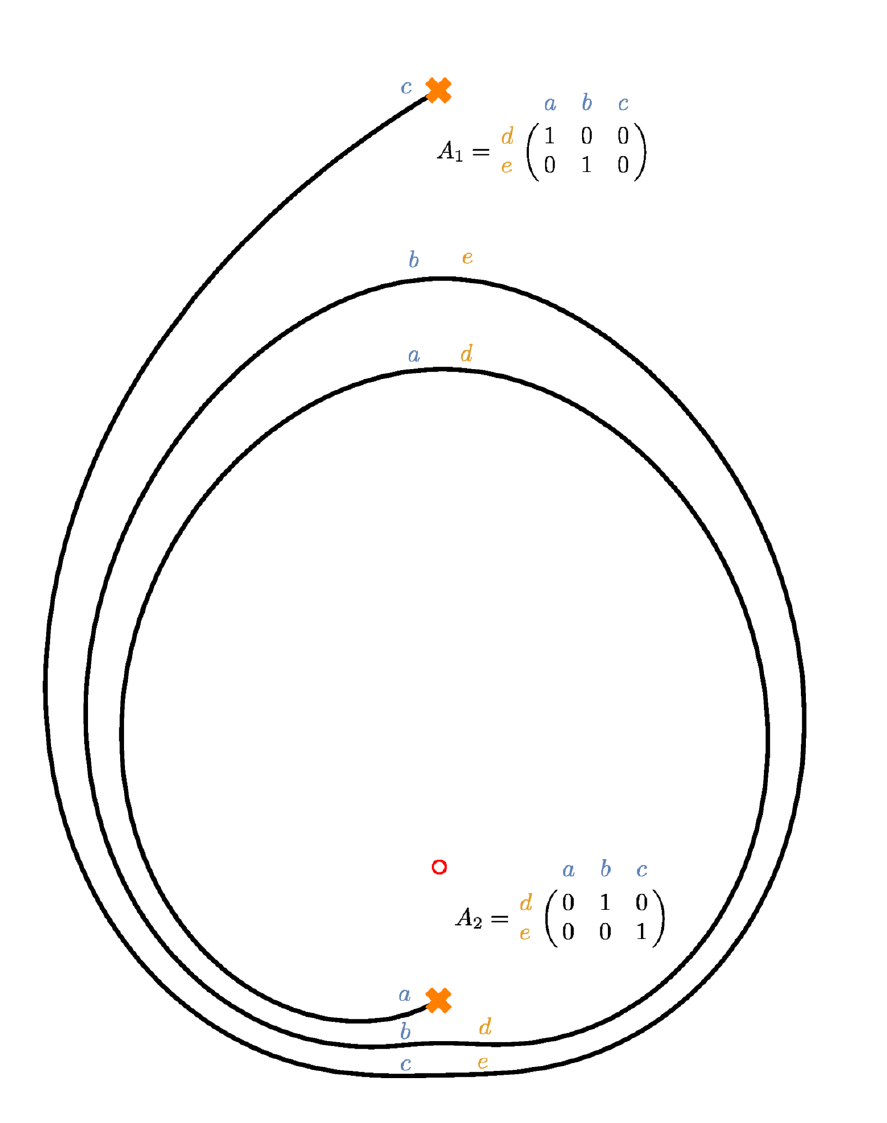
Figure 7. (3 ; 2) bound state and its corresponding quiver